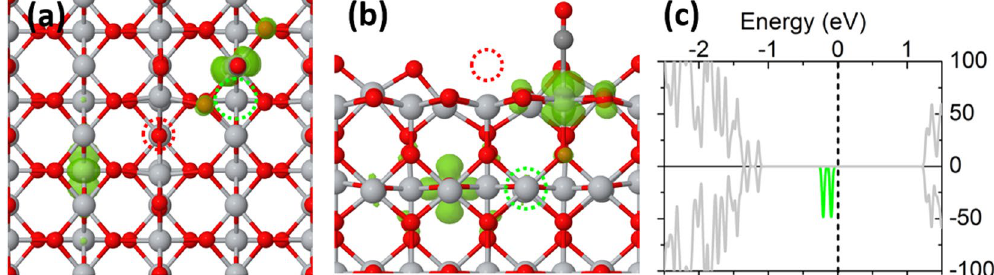
Figure 3. Structure, charge distribution of band-gap states (purple isosurface in the left and middle panels) and the corresponding DOS of CO-adsorbed TiO 2 (110) (in the right panel). Here, the CO adsorbs on the next- nearest neighboring Ti 5c of reduced surface from Vo (see the dashed red circles). Left panel: top view; middle panel: side